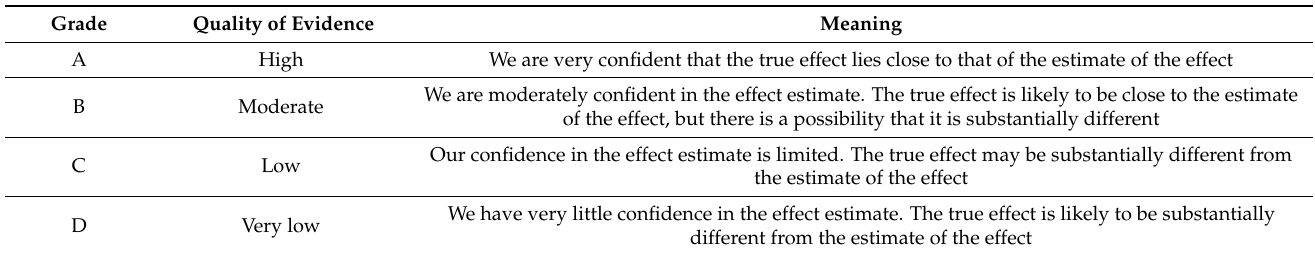
Table A1. Grade for quality of evidence [131,137].